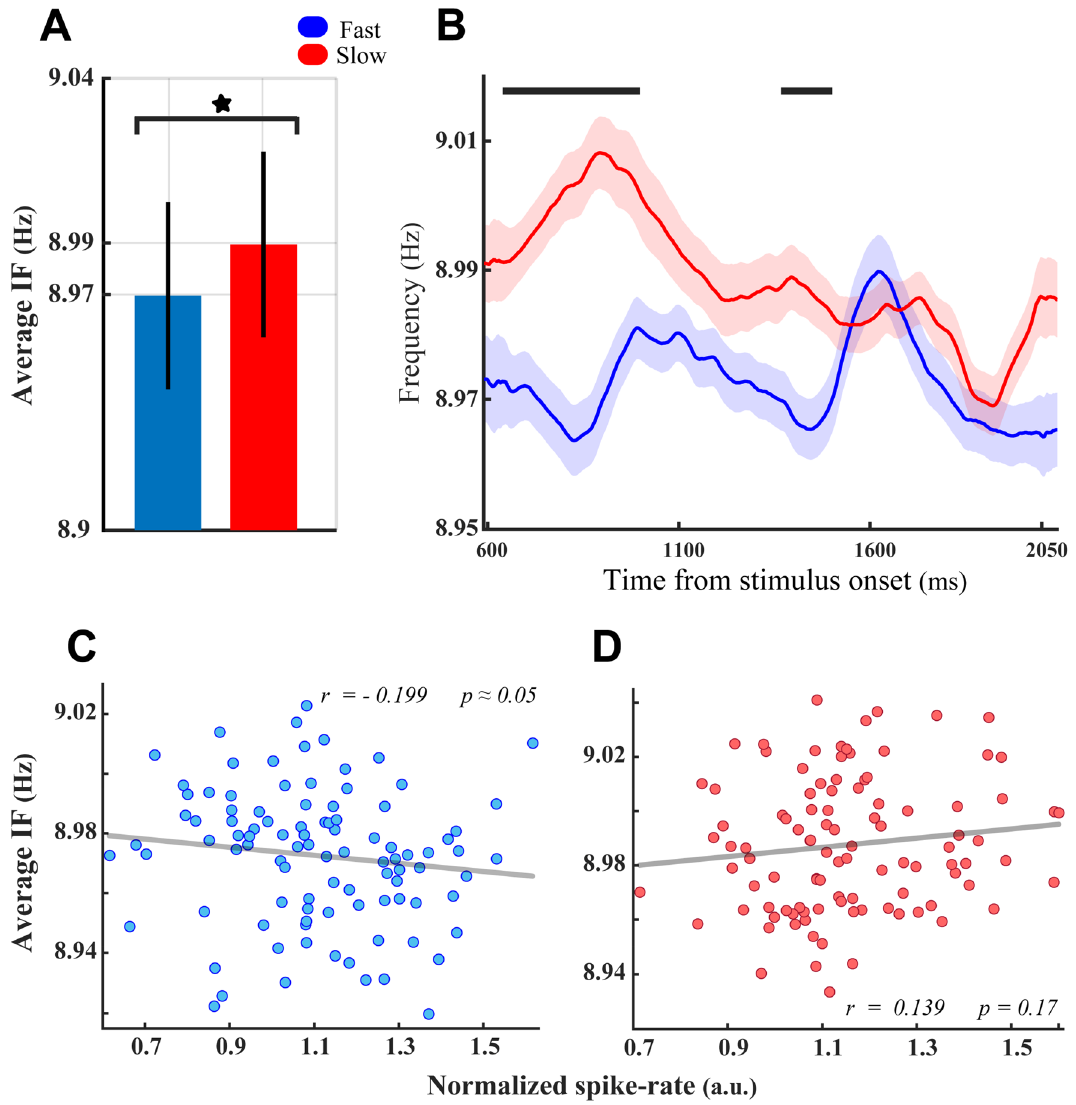
Figure 6. Functional significance of the theta–alpha frequency modulation at the target-in condition. The detailed description of ( A – D ) is the same as the panels shown in Fig. 5. ( A – D ), respectively, except the significance levels in ( A ) ( p < 8 × 10 −5 , two-sided sign-test) and ( B ) ( p < 0.014, two-sided Wilcoxon rank-sum test with FDR correction for multiple comparisons). Likewise, the inset numbers in ( C , D ) display the results of correlation analyses in fast and slow RT trials,